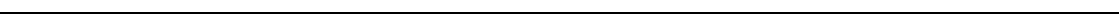
Fig. 8 Bleaching adaptation supports recovery of contrast sensitivity at high irradiance. a Experimental protocol. Ganglion cell responses in Cnga3 − / − retinas were tested at high light levels (10 5 R*rod − 1 s − 1 ), with brief (10 min) interruptions with dim light (10 2 R* rod − 1 s − 1 ). During the last three dim segments, 50 µ M 9- cis retinal was applied. b – d Relative response strength of one example ganglion cell to 2-s positive and negative contrast steps (same stimulus as in Fig. 2b), during one experimental segment at 10 5 R*rod − 1 s − 1 after 9- cis retinal application. b Spike raster. c Average fi ring rate to the last 50 repetitions of the stimulus (top) was used as a template to quantify the evolution of response strength in this experimental segment by linearly fi tting the fi rst 1000 ms of the cell ’ s response (average fi ring rate to fi ve stimulus repetitions) after each contrast transition (ON stimuli of low and high contrast, light red and red; OFF stimuli of low and high contrast, light blue and blue). d Evolution of response strength of this cell during this experimental segment, for all four contrast transitions. e , f Median relative response strength ( e ) and cumulative distribution of relative response strength ( f , for the fi rst eight time points shown in e ) across all experimental segments and all ganglion cells from four retinas recorded with an experimental protocol as in a , and two retinas recorded with a similar protocol without supplying 9- cis retinal. Test for statistical signi fi cance was performed with a permutation test (Methods). Note that the relative response strength can be < 0 and > 1 (see examples in c , d ), so that the cumulative distribution does not fully cover the range from 0 to 100% in the panels shown in